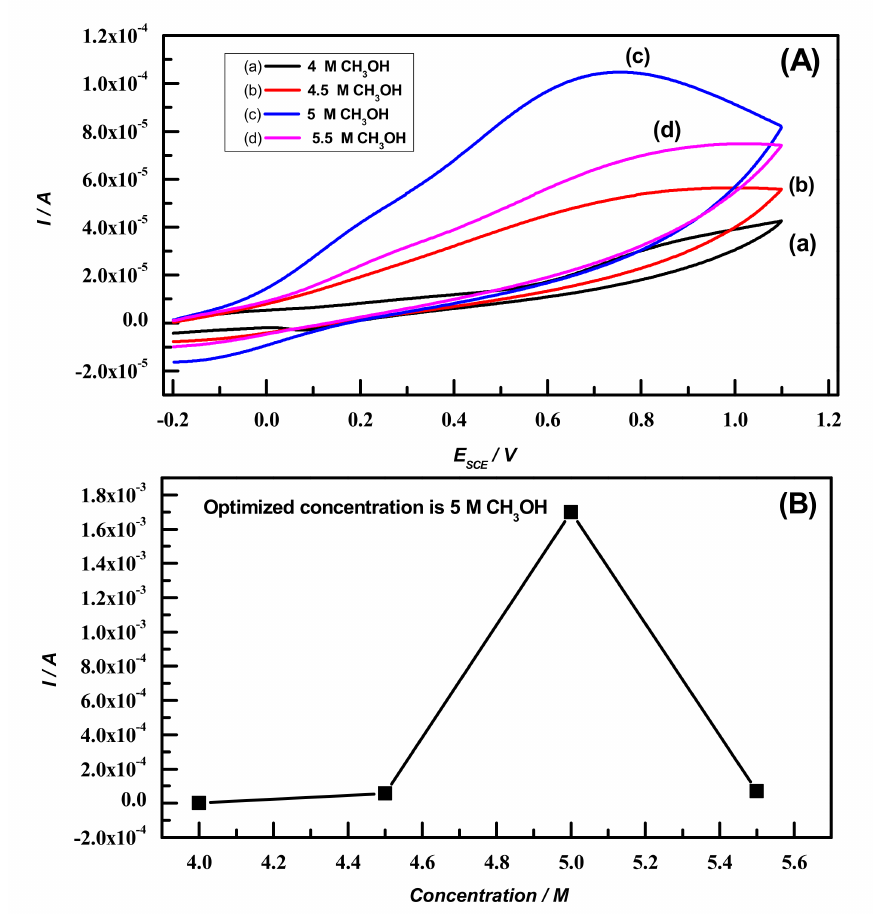
Figure 8. ( A ) CVs of PACHA coated electrodes recoded in different concentrations of methanol (as indicated) in 1.8 M NaOH at 50 mV/s; ( B ) effect of methanol concentration on anodic peak current density in 1.8 M